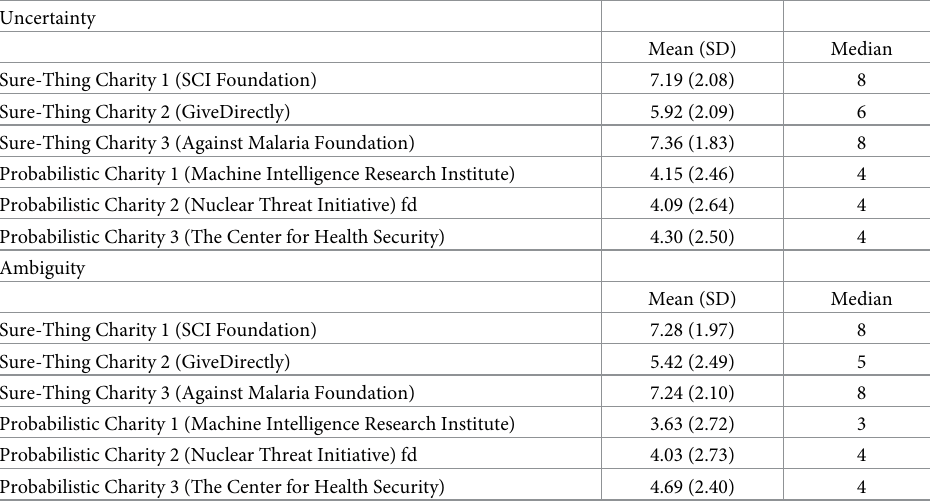
Table 1. Probability-ratings for all six charities.